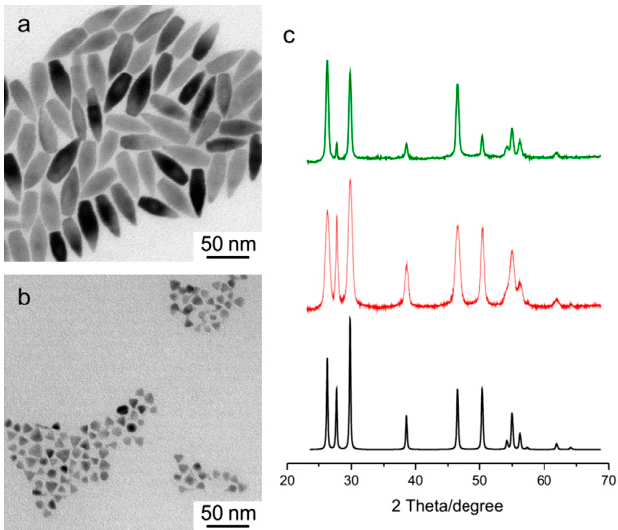
Figure 12. Colloidally synthesized CuInS 2 quantum dots made by Radychev et al. for the purpose of hybrid solar cell blends with P3HT. ( a ) TEM images of pyramidal QDs; ( b ) TEM images of elongated QDs; ( c ) XRD diffraction patterns of elongated CuInS 2 (green), pyramidal CuInS 2 (red), and bulk CuInS 2 (black). Reprinted from [70], with permission from Elsevier.